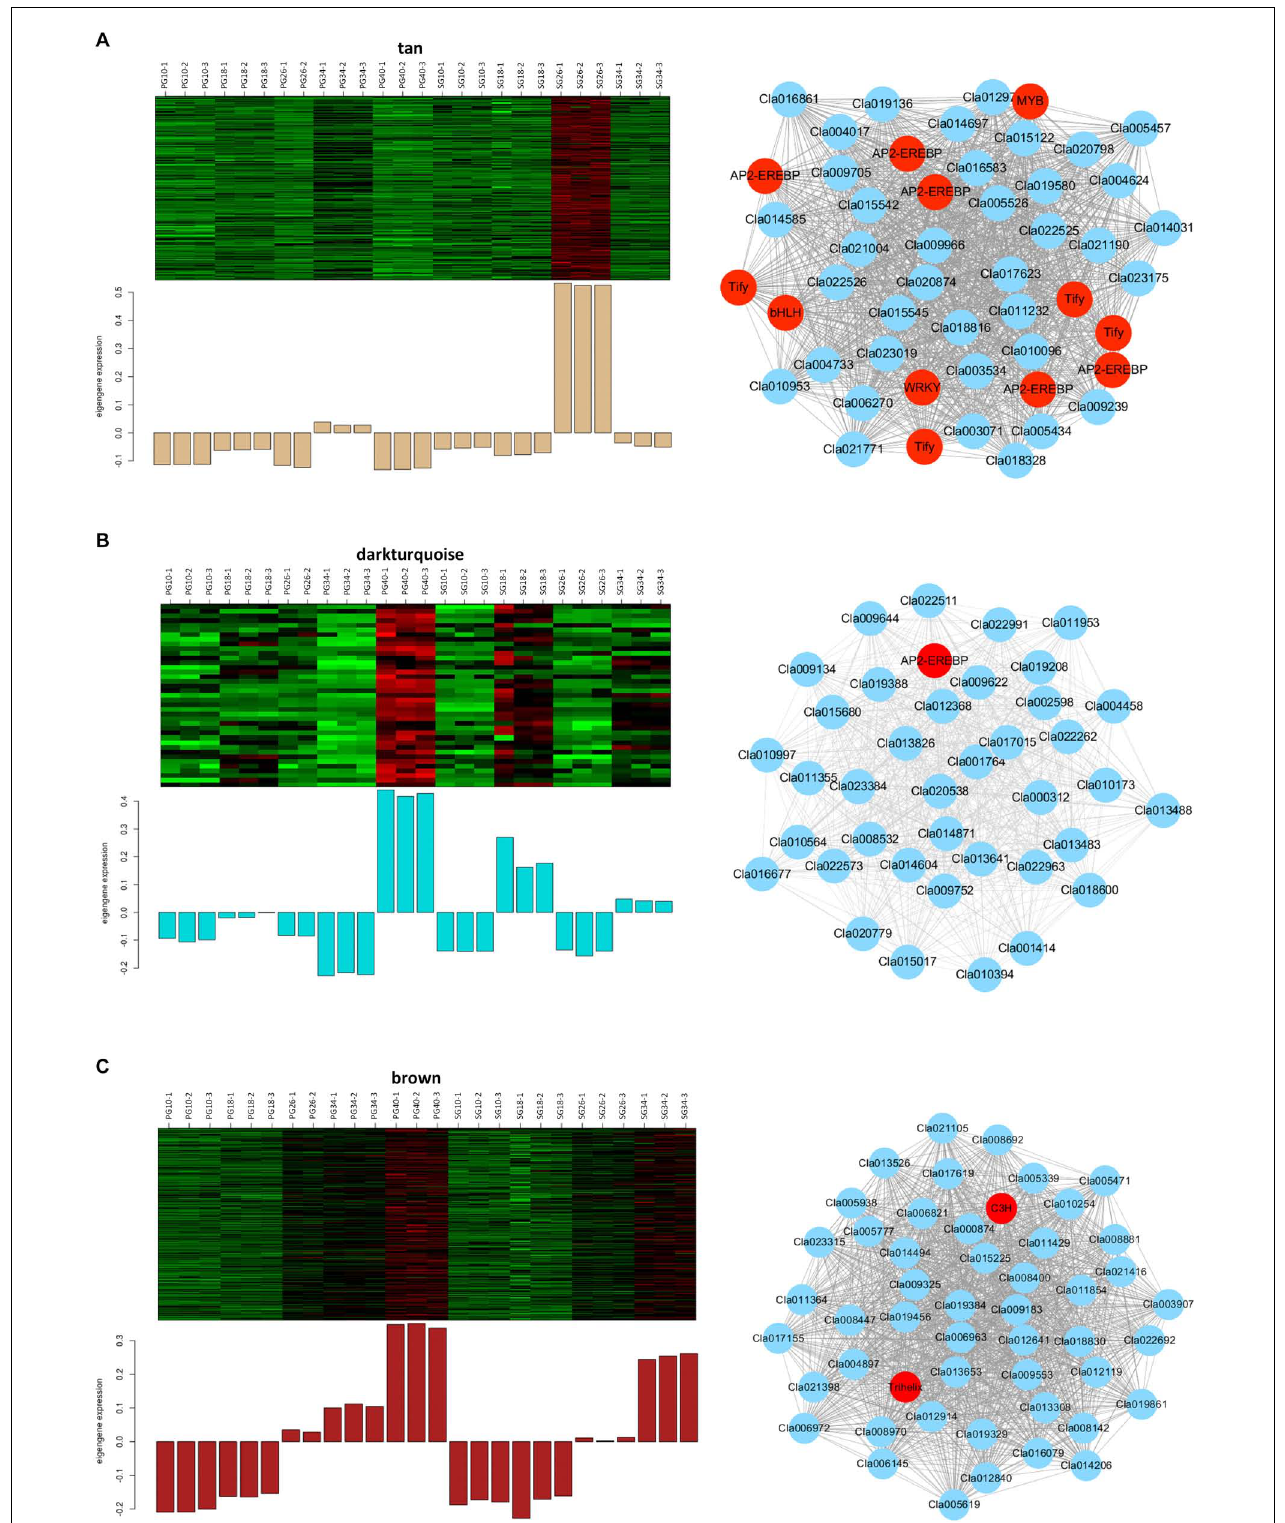
FIGURE 7 | Expression patterns and the co-expression networks of the differentially expressed genes in self-grafted (SG) watermelon plant and pumpkin-grafted (PG) watermelon plant. (A) The module correlated with SG fruit at 26 days after pollination (DAP). (B) Darkturquoise module correlated with PG fruit at 40 DAP. (C) Brown module correlated with PG fruit at 40